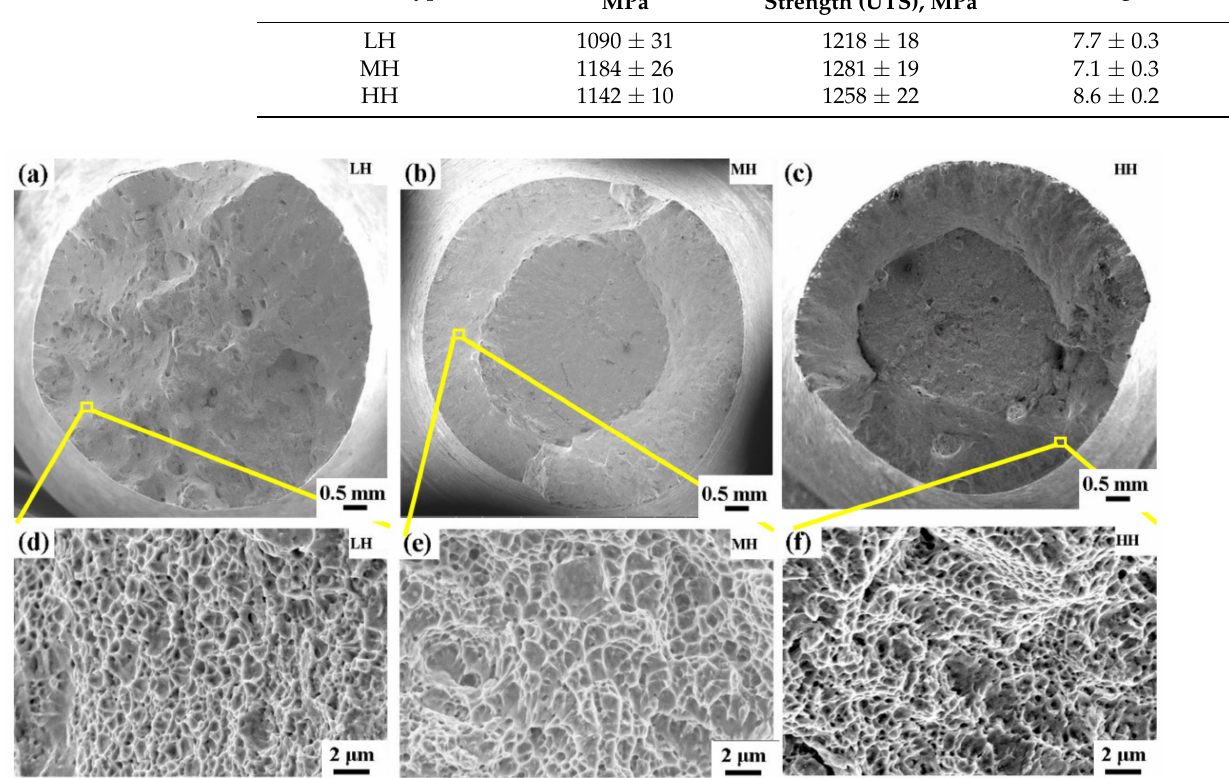
Figure 7. SEM images of the fracture surface of the SLM-processed LH ( a ) and ( d ), MH ( b ) and ( e ), and HH ( c ) and ( f )